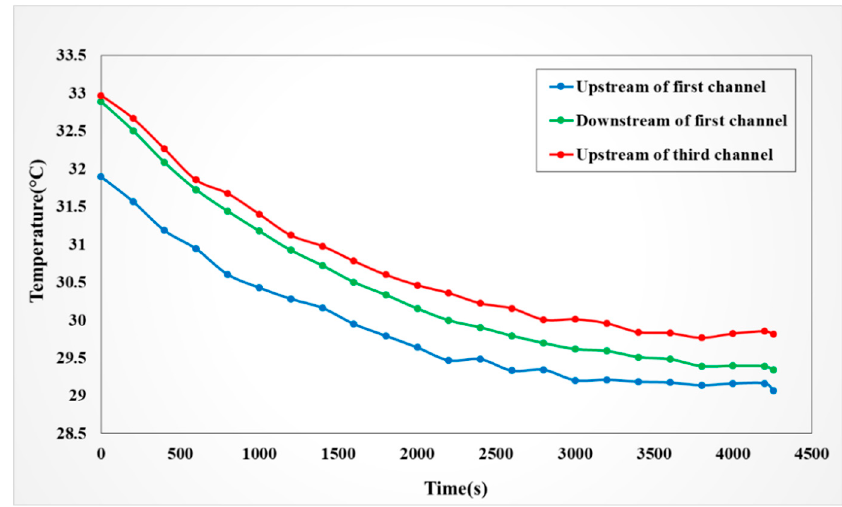
Figure 14. Temperature changes in battery in 1A constant current charging process.